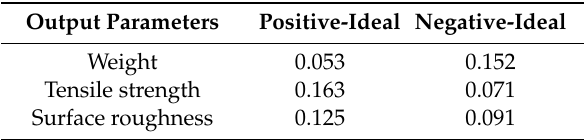
Table 6. Values of positive ideal and negative ideal